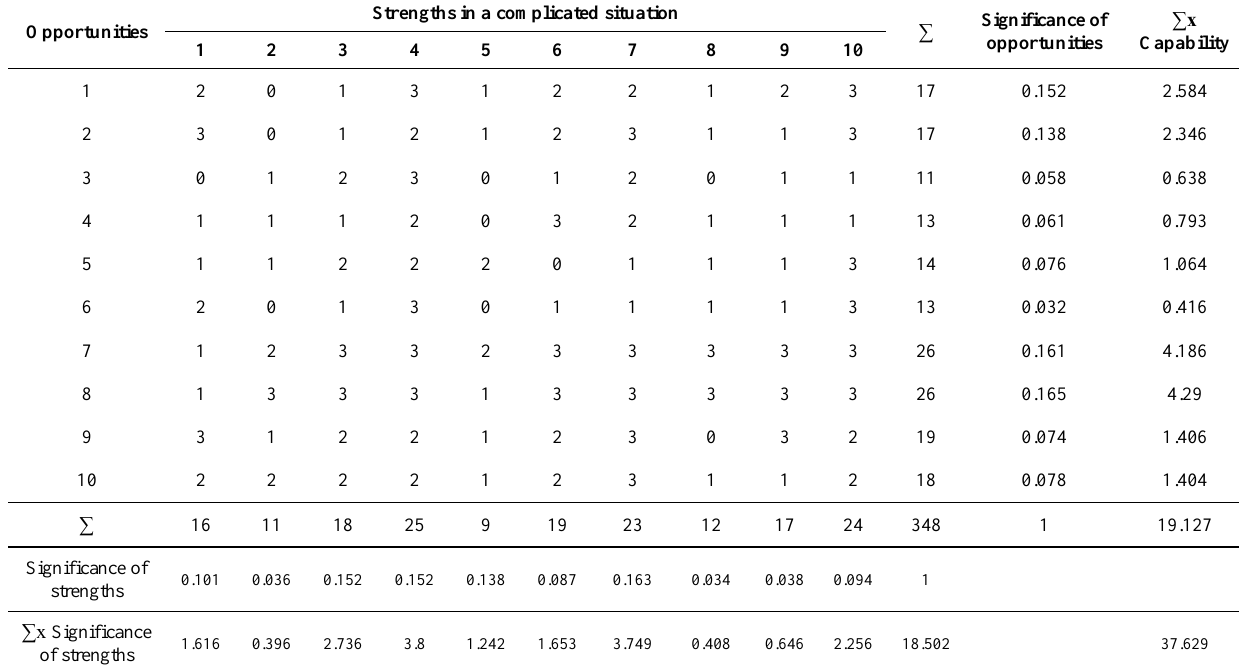
Table 4. Table determining the significance of strengths and opportunities.